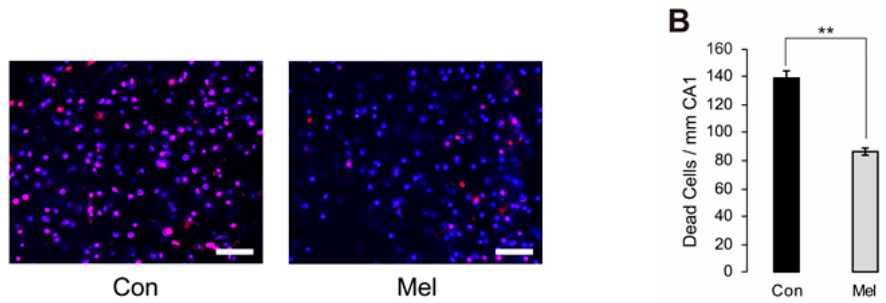
Figure 3. Comparison between control and melatonin-induced PostC groups for the number of dead neurons due to ischemic injury in the hippocampal CA1 region. ( A ) Microscopic view of the CA1 region shows the nuclei of dead cells in the control and melatonin-induced PostC groups, respectively. Magenta cells stained with both propidium iodide and SYTOX-blue were considered dead before electrophysiological recordings; blue cells stained with SYTOX-blue alone were considered dead due to ischemia-reperfusion injury. Scale bars = 50 μ m. ( B ) The number of dead neurons per 1 mm of CA1 region. The number of dead neurons was significantly lower in the melatonin-induced PostC group according to t-testing (** p < 0.01). Con—control; Mel—melatonin.